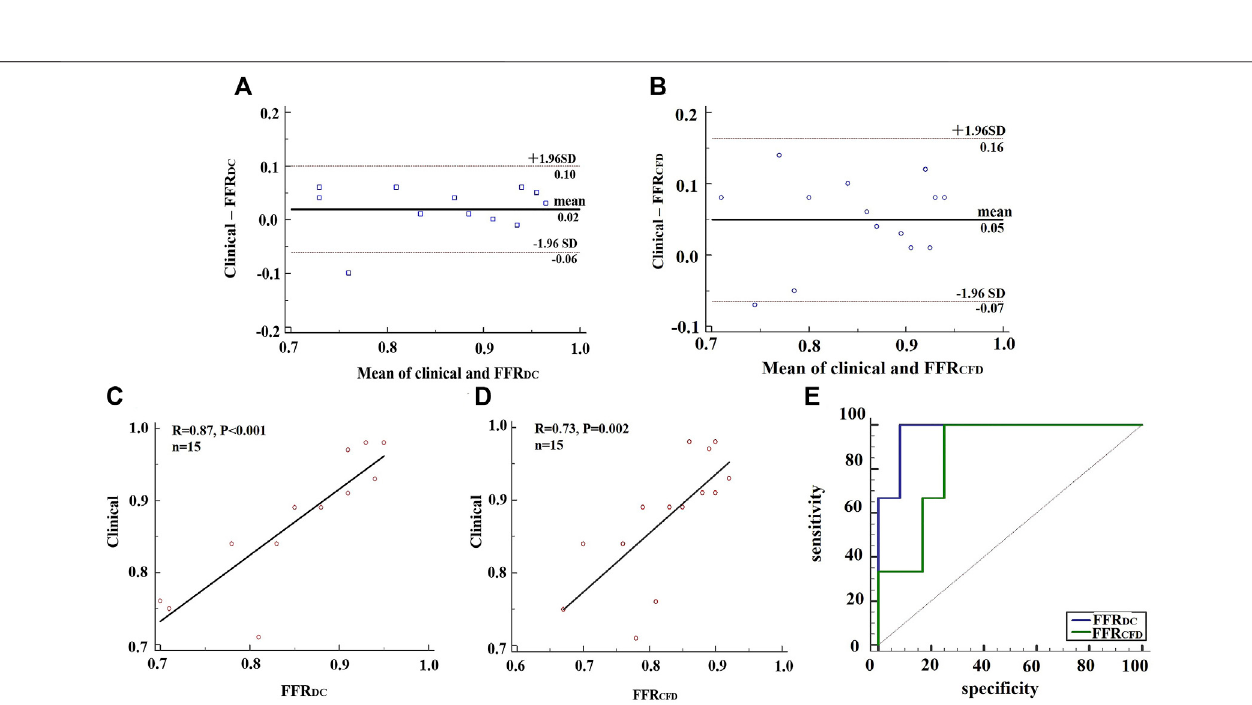
FIGURE 7 | Analysis of clinical FFR data, FFRDC and FFRCFD. (A) BlandAltman plots for the pairwise comparisons of clinical FFR data and FFRDC. (B) BlandAltman plots for the pairwise comparisons of clinical FFR data and FFRCFD. (C) A comparison of clinical FFR data and FFRDC. (D) A comparison of clinical FFR data and FFRCFD. (E) ROC analysis of FFRDC and FFRCFD, using clinical FFR data as a reference.